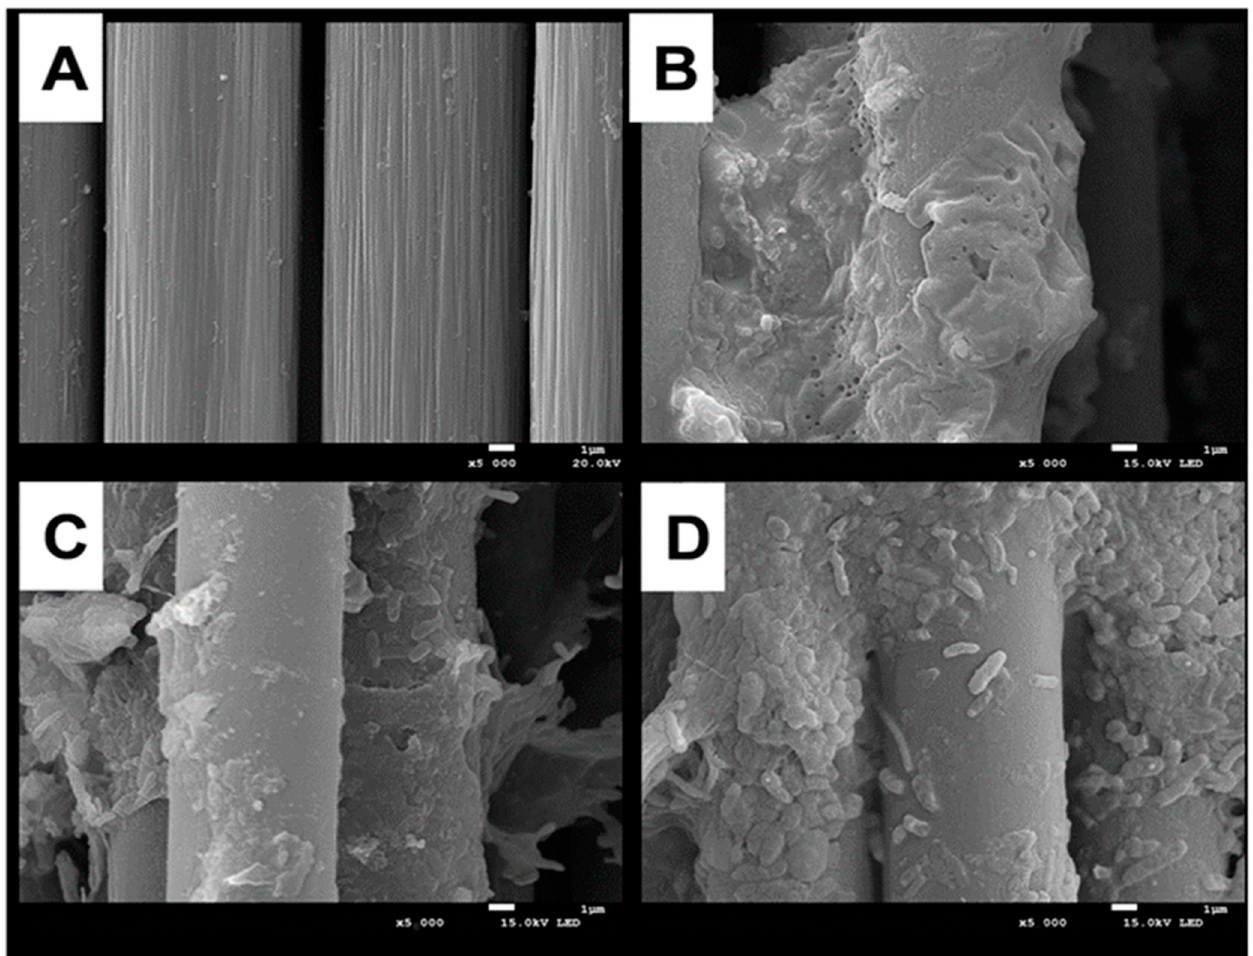
Figure 3. Comparative SEM morphological analysis of the differences in the anodic electroactive biofilms of MFCs at different pH conditions. ( A ): sterile control; ( B ): pH = 6.0; ( C ): pH = 5.0; ( D ): pH = 4.0.